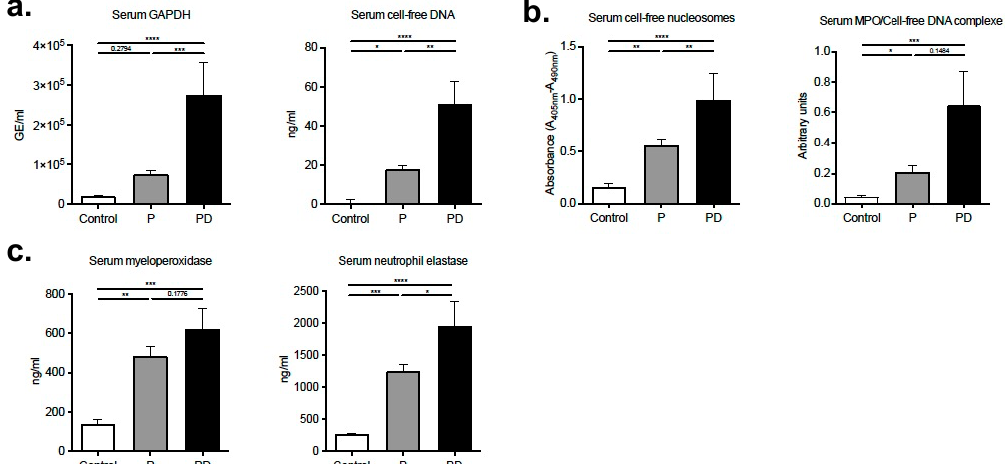
Figure 1. Markers of NETosis and neutrophil degranulation are substantially increased 48 h post- delivery ( a ) Cell-free DNA levels in serum from donors during pregnancy ( n = 12), 48 h postpartum ( n = 9) and healthy matched blood donors ( n = 11), determined by GAPDH real-time PCR (left panel) and dsDNA-binding fluorescent dye quantification (right panel). ( b ) Cell-free nucleosome levels in serum from healthy donor controls, donors during gestation and postpartum, determined by ELISA and NET-associated MPO/DNA complexes quantified utilizing a modified capture ELISA. ( c ) Neu- trophil and peripheral blood mononuclear differential cell counts in healthy non-pregnant blood donors, donors during pregnancy and 48 h postpartum. P: pregnancy; PD: post-delivery. Data are presented as mean ± SEM. * p < 0.05, ** p < 0.01, *** p < 0.001, **** p < 0.0001.